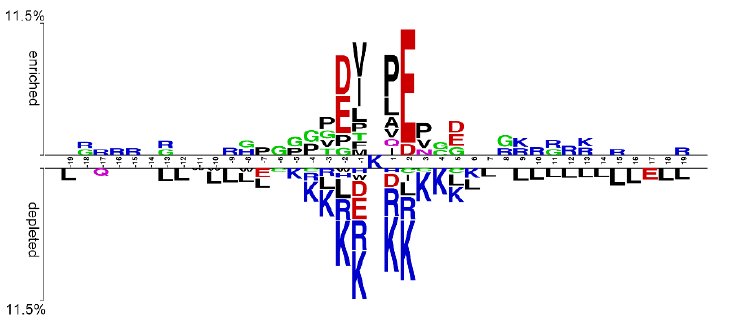
Figure 3. Sequence pattern surrounding the SUMOylation sites, including the significantly enriched and depleted residues based on SUMOylation-containing peptides and nonmodified peptides in our dataset ( p < 0.05, t -test with Bonferroni correction). The pattern was generated using the two-sample logo method (Vacic et al.